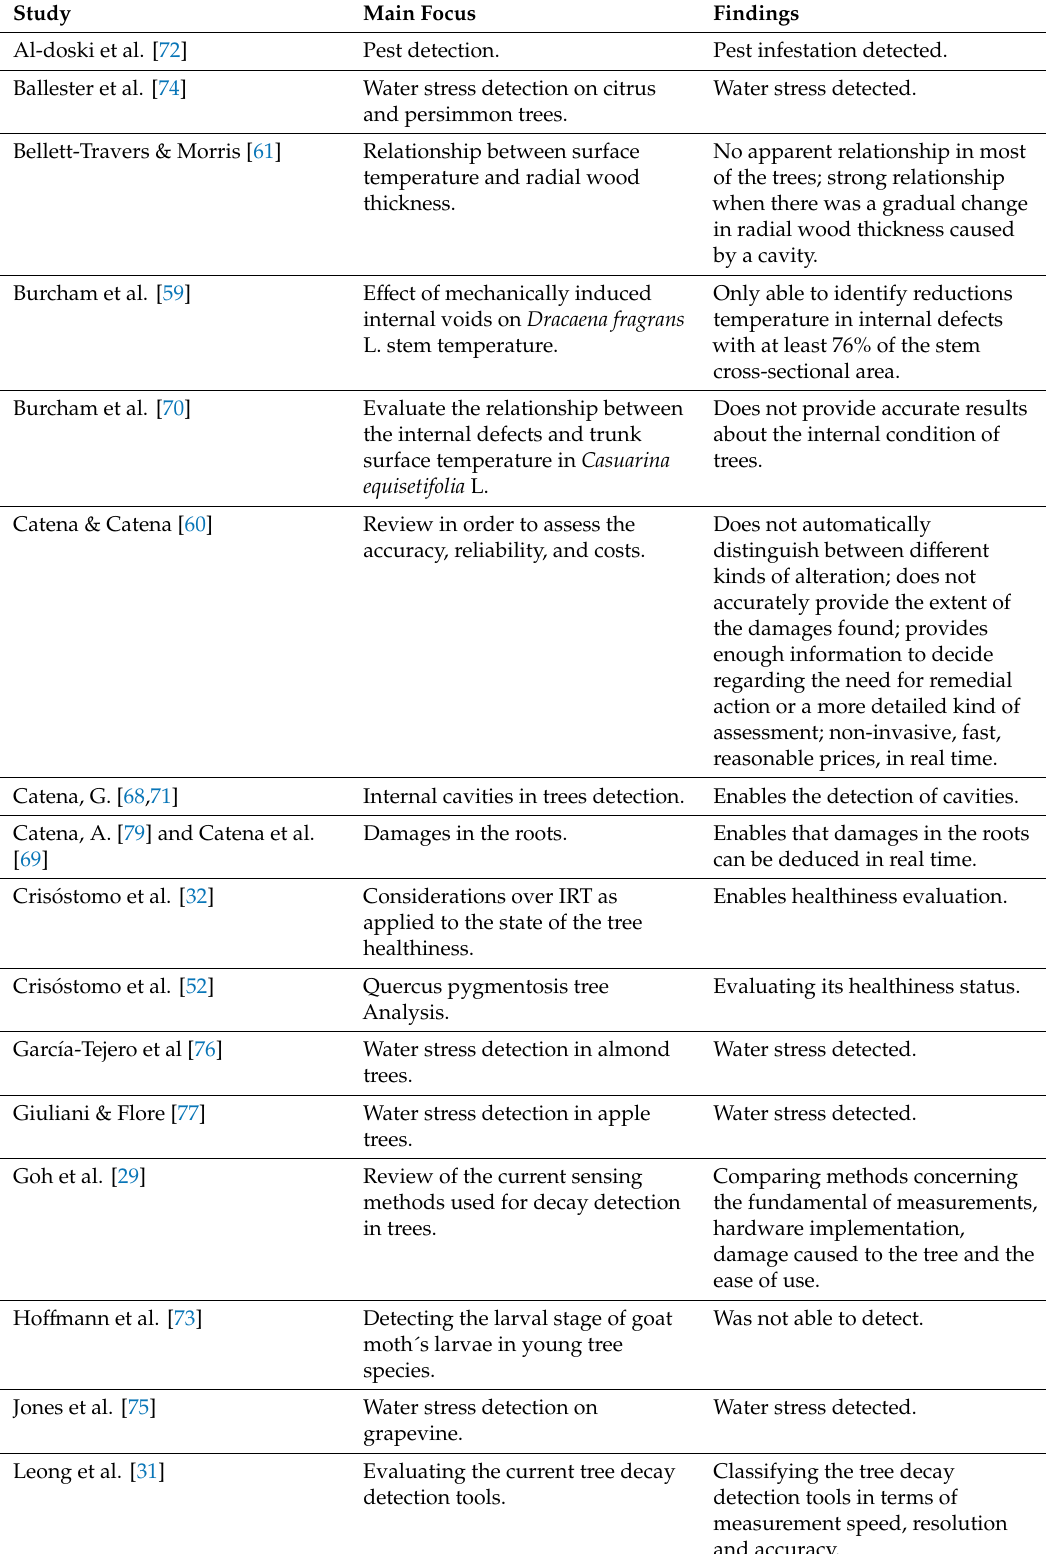
Table 3. A short summary of infrared thermography applied to tree health